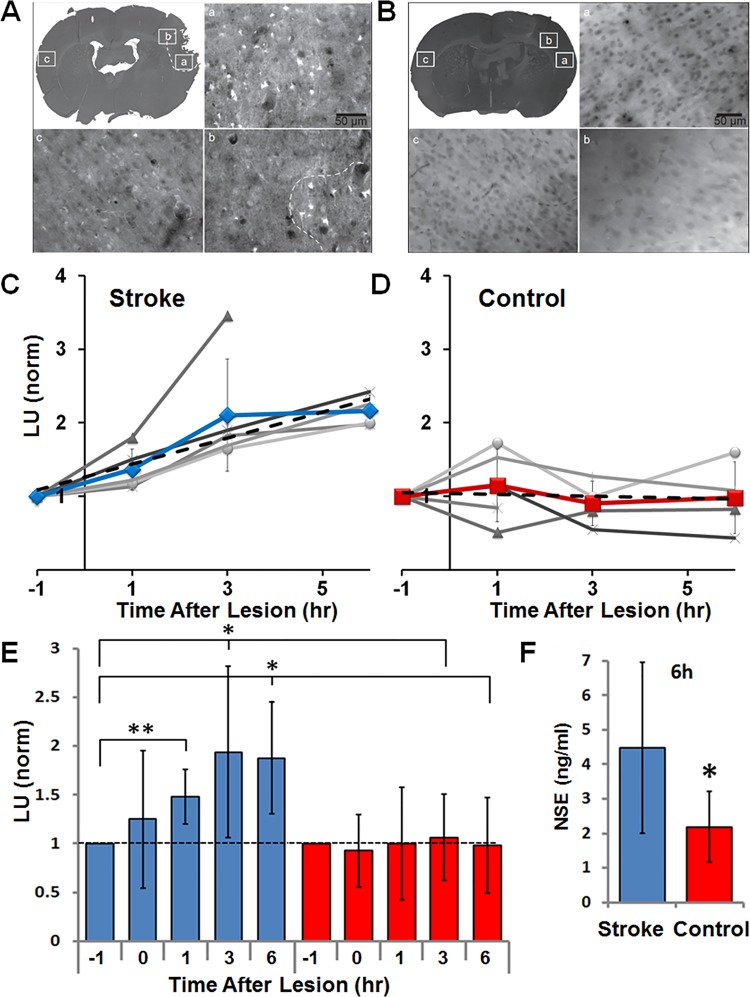
Using NP-PK and NP-Luc for rapid detection of NSE in a rat model for stroke.
A) Fluoro Jade-C staining for measurement of damaged brain tissue volume. The presence and absence of FJC-labeled degenerative neurons were imaged with epifluorescence under 20x magnification using filters for FITC. (a) Region with abundant FJC staining (bright cells) on lesioned side. (b) Region at the edge of FJC staining. (c) Region that is contralateral to (a) that did not show any FJC staining. Dotted line in B and low magnification inset indicates manually-mapped border between FJC positive and negative areas. B) FJC staining in control brain section. (a) and (b) are in area of craniectomy. C-D) Individual rat data (C-stroke and D-control) for NSE measurements at each time point (grayscale lines indicate data points for individual animals, line with symbol indicates the mean±standard deviation) as performed by tethered PK and Luc assay, and normalized to time point -1 hour. Plasma samples were collected from stroke induced or control rats pre (-1 hr), and post occlusion (0, 1, 3 and 6 hr). The mean slope of the trend (dashed line) was calculated averaging individual slopes in each group (stroke = 0.26 with 0.95 confidence interval, control = -0.02 with 0.38 confidence interval). E) Summary of rat stroke model experiments showing a statistically significant increase in NSE plasma levels in stroke (blue bars) vs. control (red bars) rats as soon as 1 hour post occlusion. F) Measurements of NSE in plasma from rats using ELISA showed elevated levels in stroke compared to control rats at the last time point (6 hr post-occlusion). P values– 0.05<*<0.1, 0.01<**<0.05. Data from 10 rats were included in our analysis, with the exclusion of 3 hour and 6 hour time points for one control animal that died (at 2 hour mark), and a 6 hour time point for a stroke animal which died and was found to have a large hemorrhage at the base of the brain.